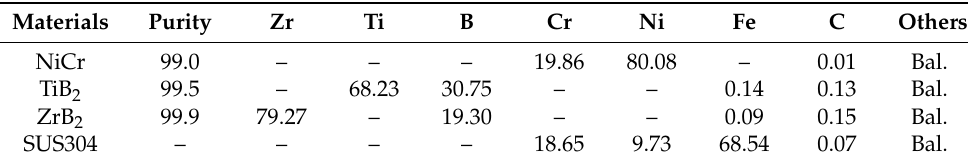
Table 1. Composition of the raw materials